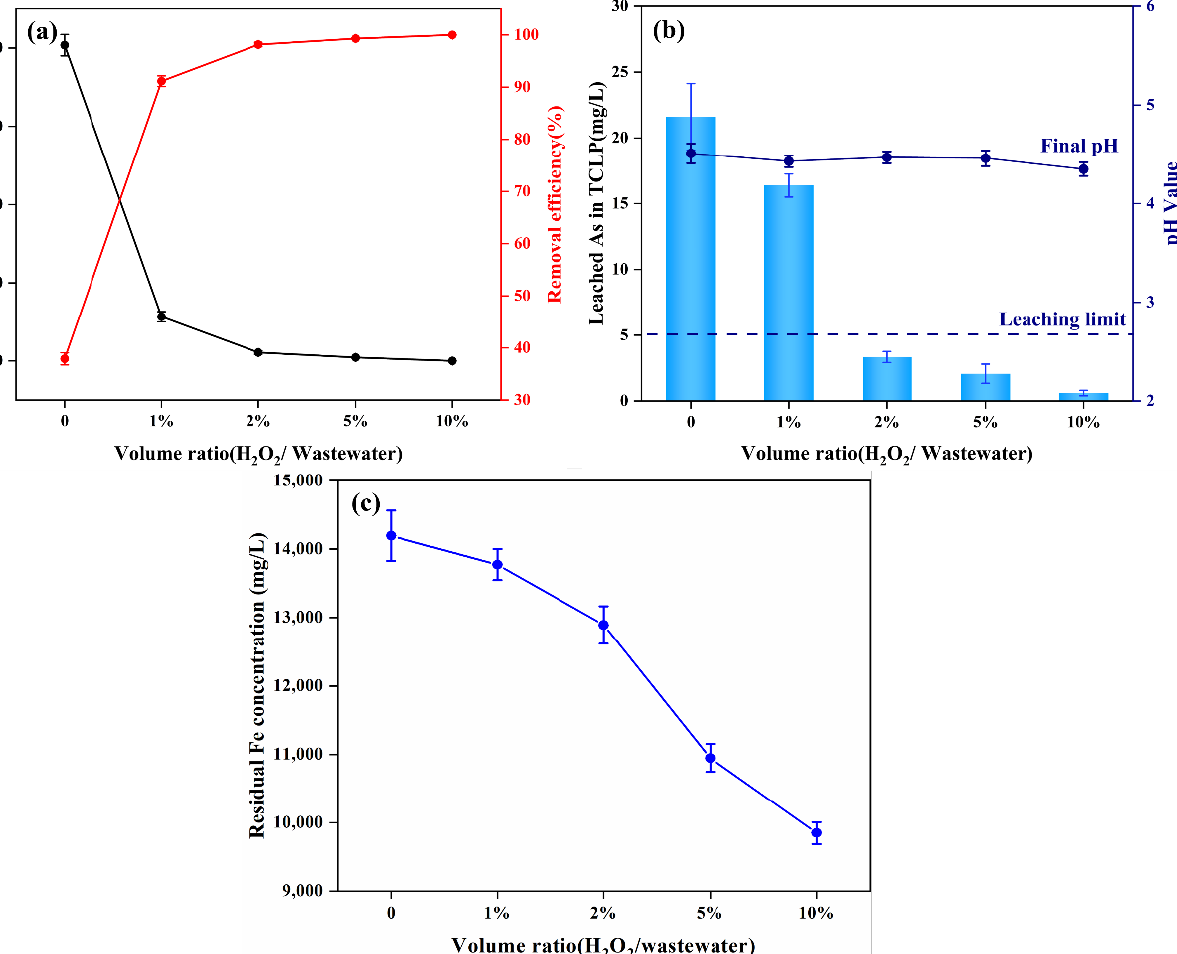
Figure 3. Variations of residual concentration and removal efficiency of As ( a ), leached arsenic concentration in TCLP and final pH value of wastewater ( b ), residual concentration of Fe ( c ) in bath experiments at volume ratio (H 2 O 2 /wastewater) of 0%, 1%, 2%, 5%, and 10%.